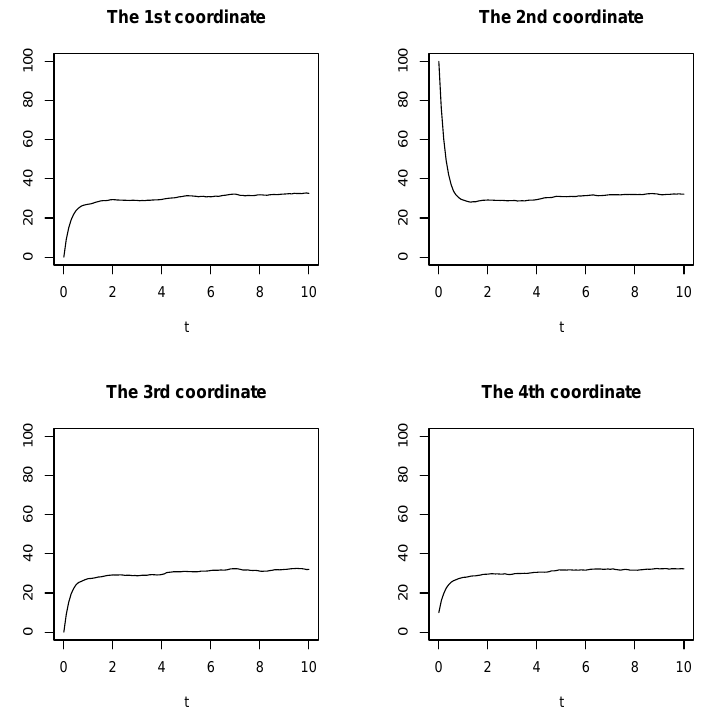
Figure 4. The trajectories of a sample solution to Example 2, where H =